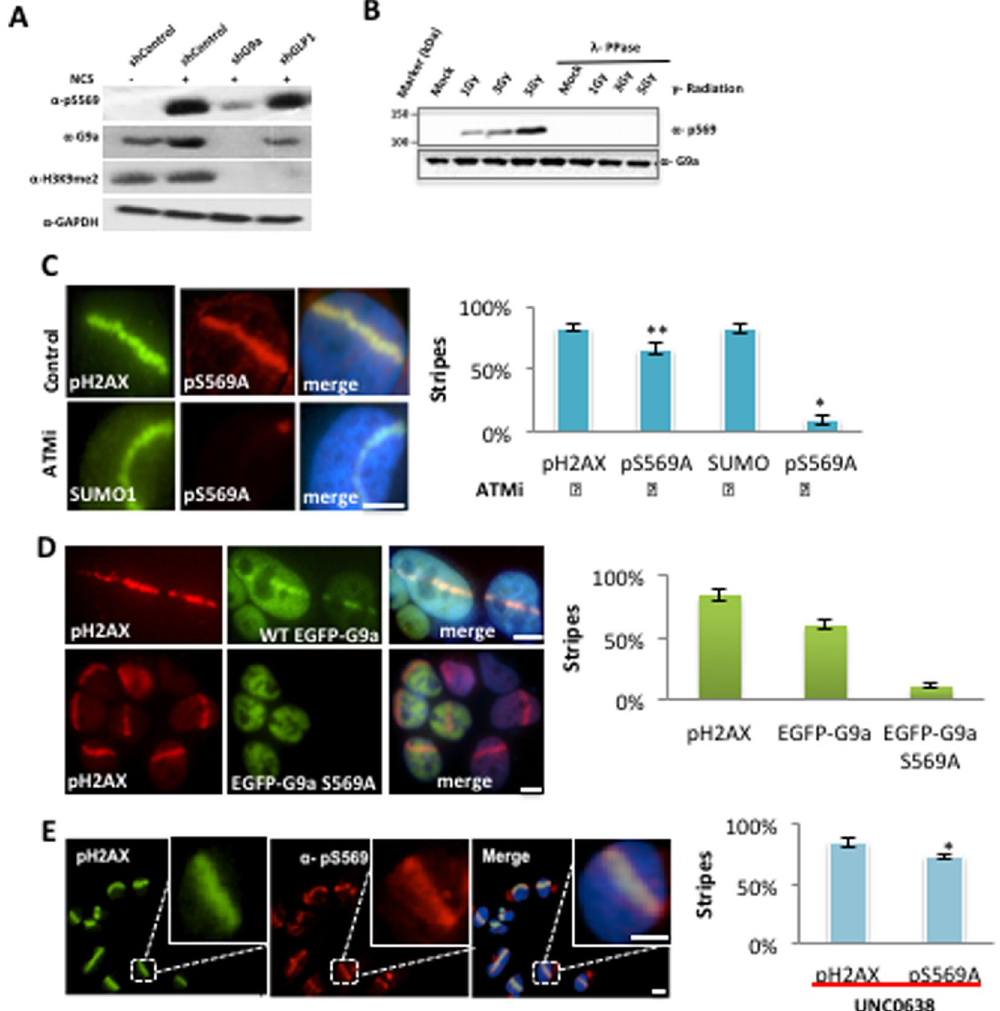
Figure 4. Phosphorylation of G9a on S569 is required for G9a recruitment to DNA breaks. ( A ) Western blots of U2OS cells expressing control or indicated shRNA, and NCS or vehicle, probed with indicated antibodies. ( B ) Western blots of U2OS cells treated with IR and probed with antibodies against pS569-G9a or total G9a. L-phosphatase treatment of extracts is as labeled. ( C ) U2OS cells treated with control or ATMi, treated with micro-irradiation and processed for IF using indicated antibodies. ( D ) U2OS cells were transfected with either EGFP-G9a or EGFP-G9a S569A mutant, and treated with micro-irradiation. Localization of endogenous pH2AX (red) and ectopic GFP-fusion proteins (green) are shown. E, U2OS cells were treated with UNC0638, and localization of pH2AX and pG9A S569 to regions of micro-irradiation are shown. Data are expressed as the mean ± SEM of at least three experiments. ** P < 0.01, * P < 0.05. Scale bar, 5 μ